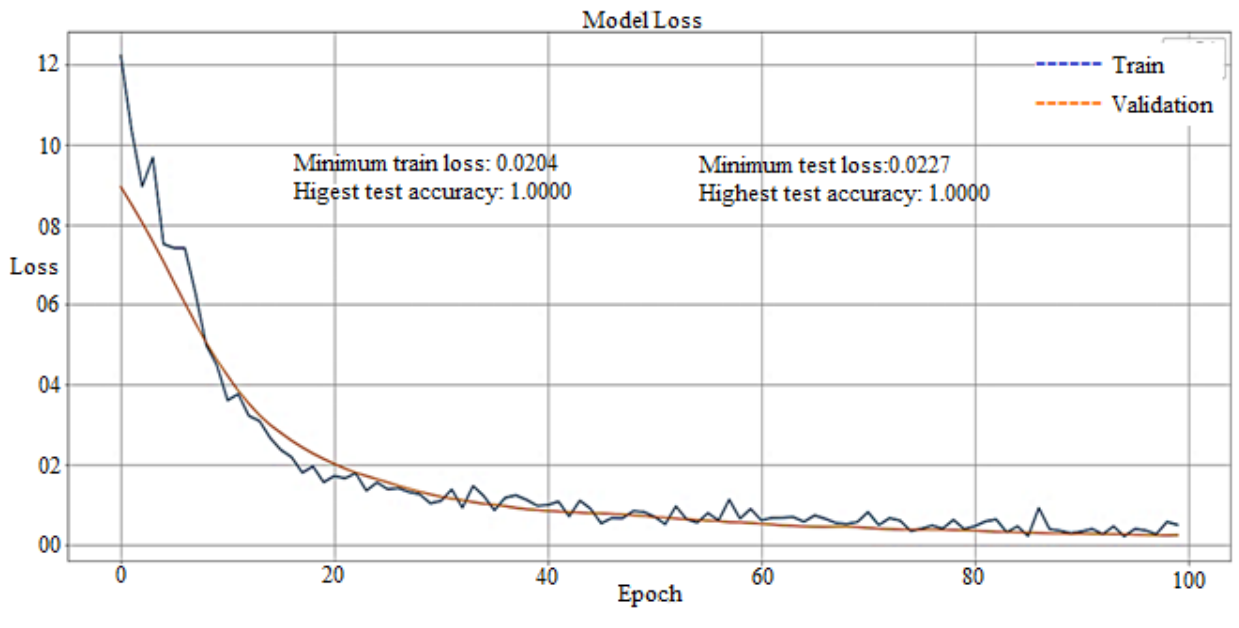
Figure 13. Accuracy curve of the model.